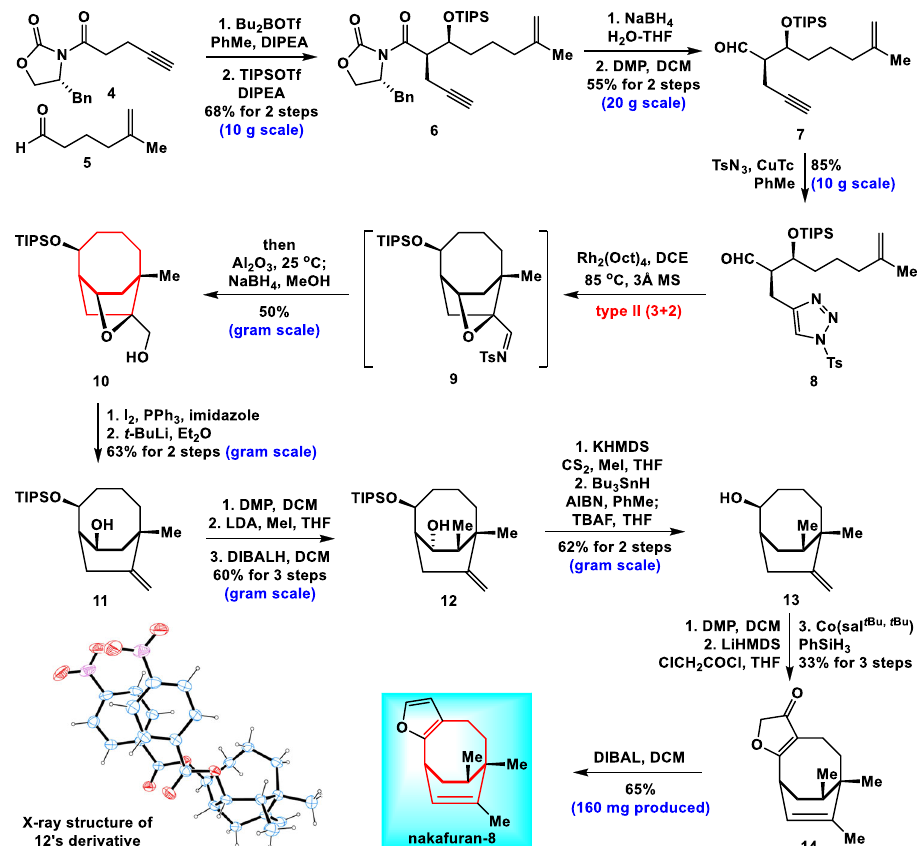
Fig. 3 Asymmetric total synthesis of nakafuran-8. DIPEA N , N -diisopropylethylamine, DMP Dess – Martin periodinane, LDA lithium diisopropylamide, DIBAL diisobutylaluminium hydride, KHMDS potassium bis(trimethylsilyl)amide, LiHMDS lithium